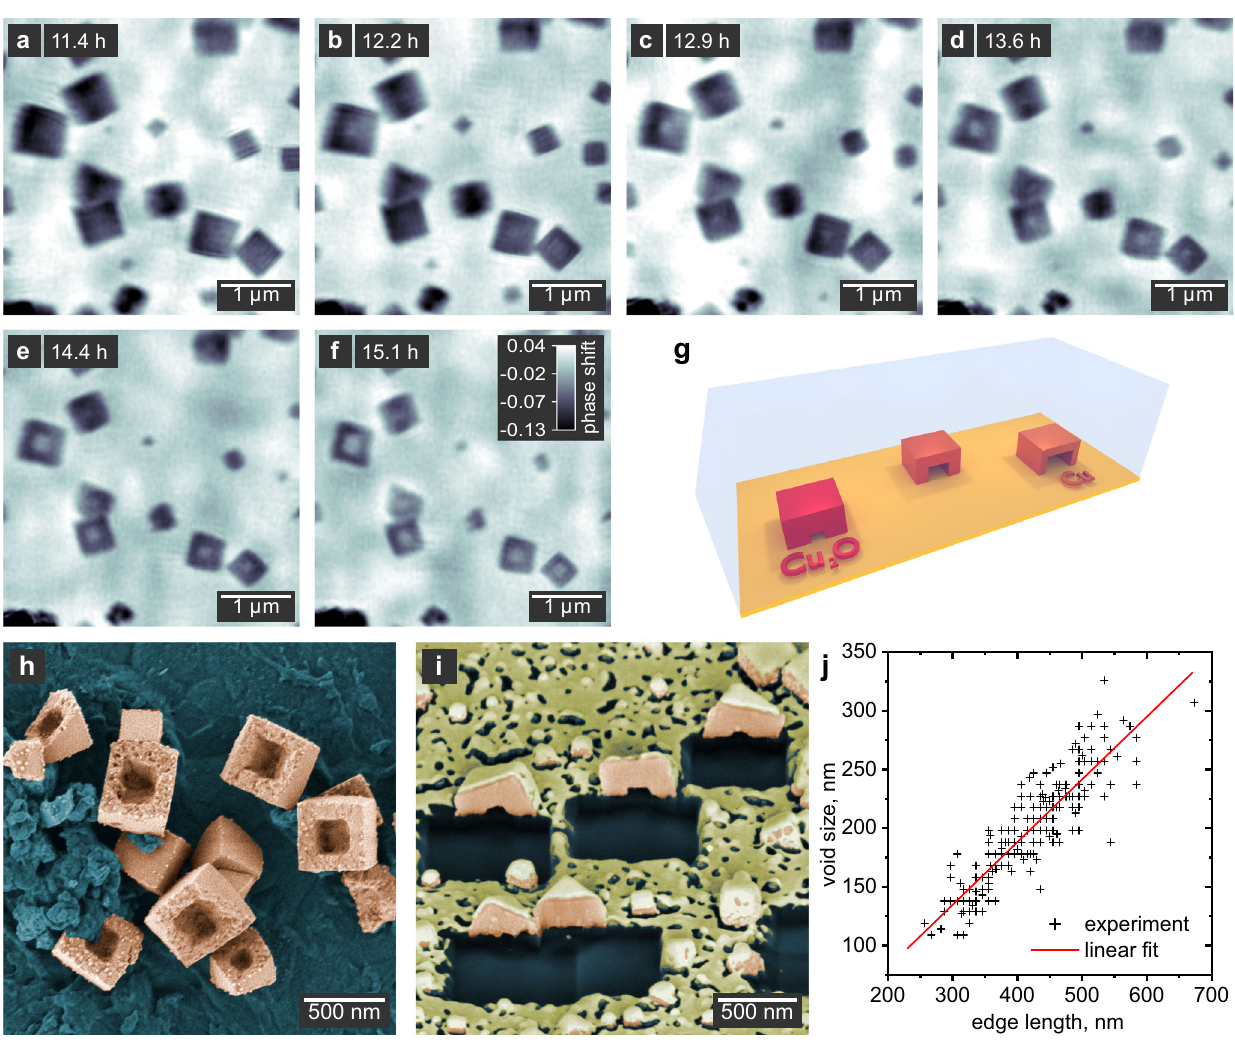
Fig.5|Hollowingprocessofthenanocuboids.a – f Ptychographic images of the hollowing process between 11.4 and 15.1h reaction time. The gray scale indi- catesthephaseshiftoftheimagesinradian. g Schematicillustrationofthevoid formation. h False-colored SEM image of bowl-shaped hollow nanocuboids (orange) taken from the same sample used for the in situ imaging in a – f . i SEM image of hollow nanocuboids cut in half using a FIB. These particles were